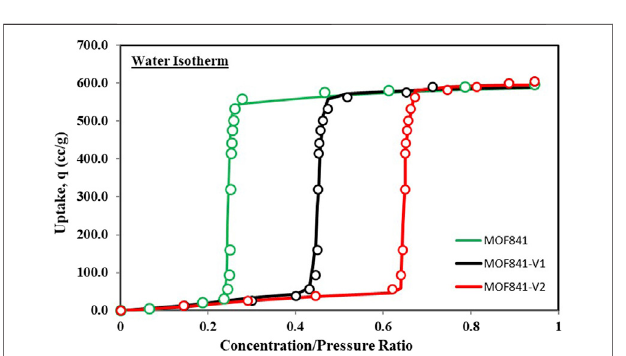
FIGURE 7 | Energy distribution function (EDF) curves for MOF 801 and variants.